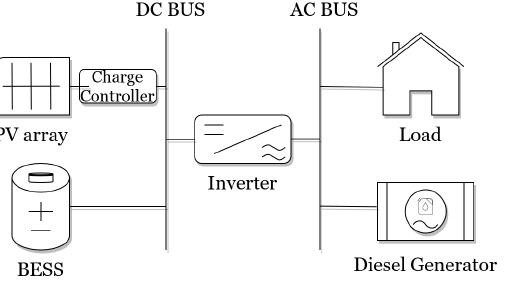
Figure 1. Islanded microgrid.